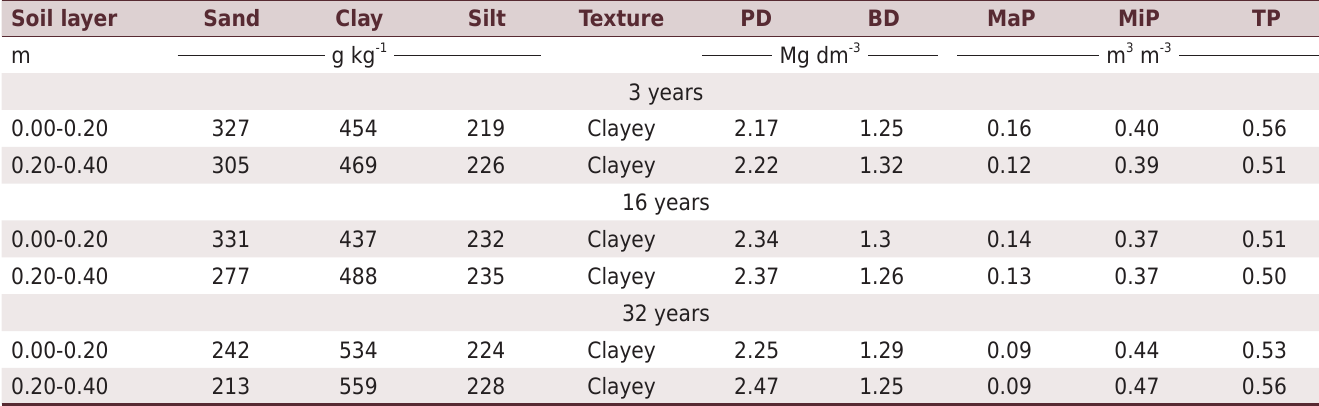
Table 1. Soil physical characterization of an Ultisol in areas cultivated with coffee with different deployment times (3, 16, and 32 years), at 0.00-0.20 and 0.20-0.40 m layers Soil layer